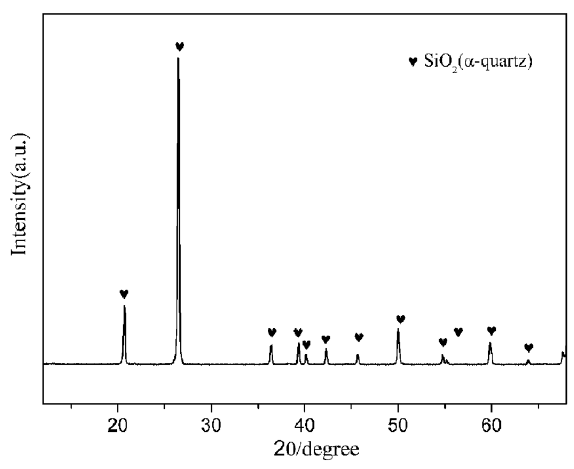
Figure 1. X-ray di ff raction (XRD) pattern of natural Figure 1. X-ray diffraction (XRD) pattern of natural quartz. Table 1. Compositional design of the samples (wt.%).